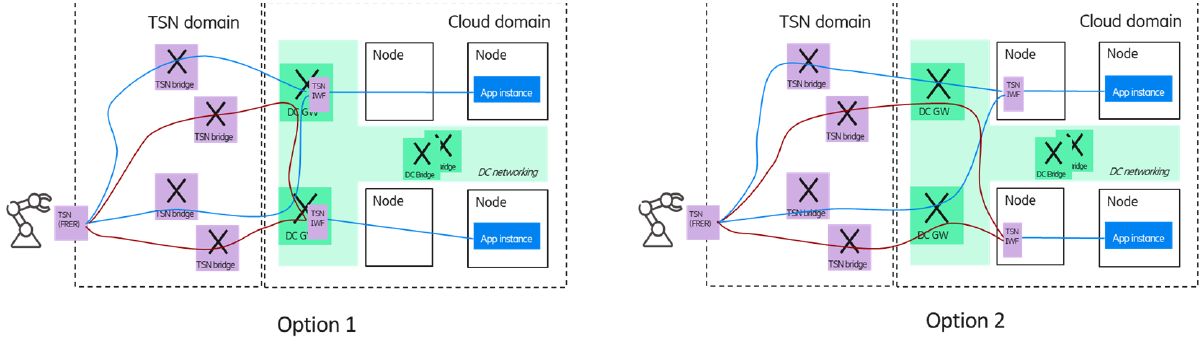
Figure 8. TSN FRER in the DC GW/TSN FRER in the edge cloud domain.